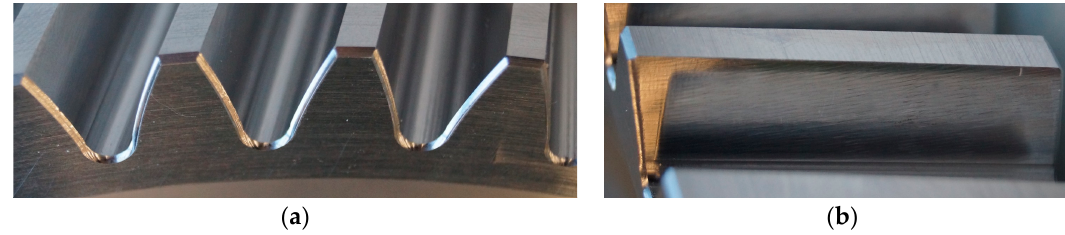
Figure 4. Quality of the soft manufactured test gear: ( a ) transverse view on the gear profile; ( b ) lateral view on the gear flank.